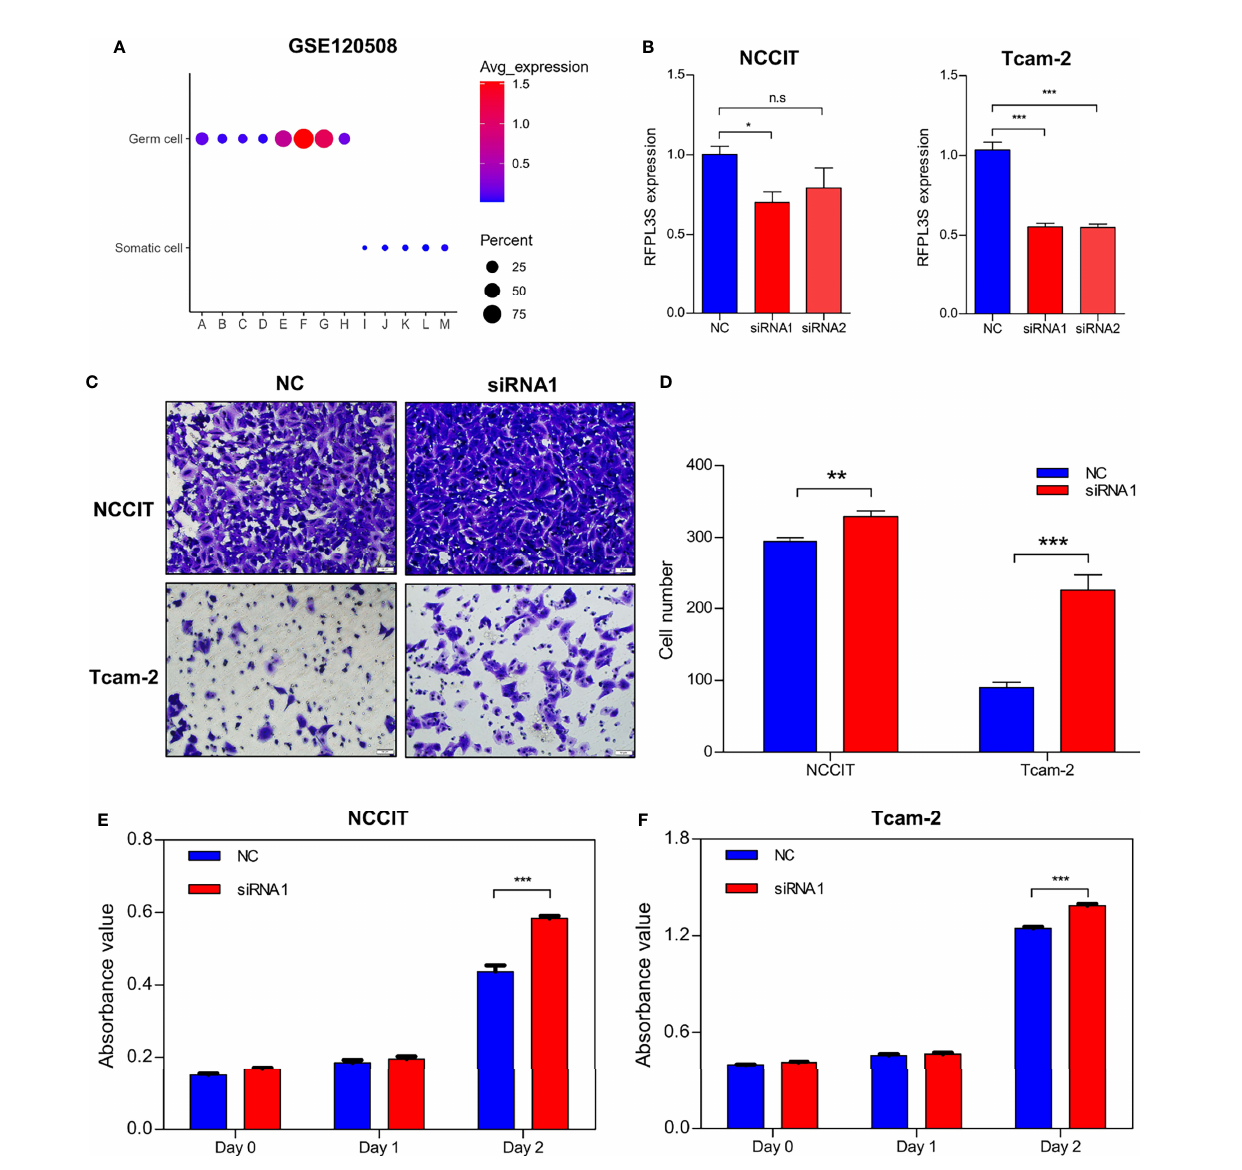
FIGURE 3 | Knockdown RFPL3S inhibits invasion and proliferation of NCCIT and Tcam-2 cells. (A) The single-cell sequencing data of GSE120508 analyzes the expression of RFPL3S in different cell types, showing that RFPL3S mainly expressed in germ cell. (A: spermatogonial stem cells; B: spermatogonia in differentiation; C: primary spermatocytes; D: secondary spermatocytes; E: round spermatozoa; F: elongated spermatozoa; G: sperm 1; H: sperm 2; I: macrophages; J: endothelial cells; K: muscle-like cells; L: support Cell; M: mesenchymal cell.). (B) siRNA transfection knocked down RFPL3S in NCCIT and Tcam-2 cells. (C, D) Silencing RFPL3S signi fi cantly enhanced the invasion ability of NCCIT and Tcam-2 cells evaluating by Transwell assay. (E, F) Silencing RFPL3S signi fi cantly enhanced the proliferation ability of NCCIT and Tcam-2 cells evaluating by CCK-8 experiment. *P < 0.05, **P < 0.01, ***P < 0.001. n.s, no signi fi